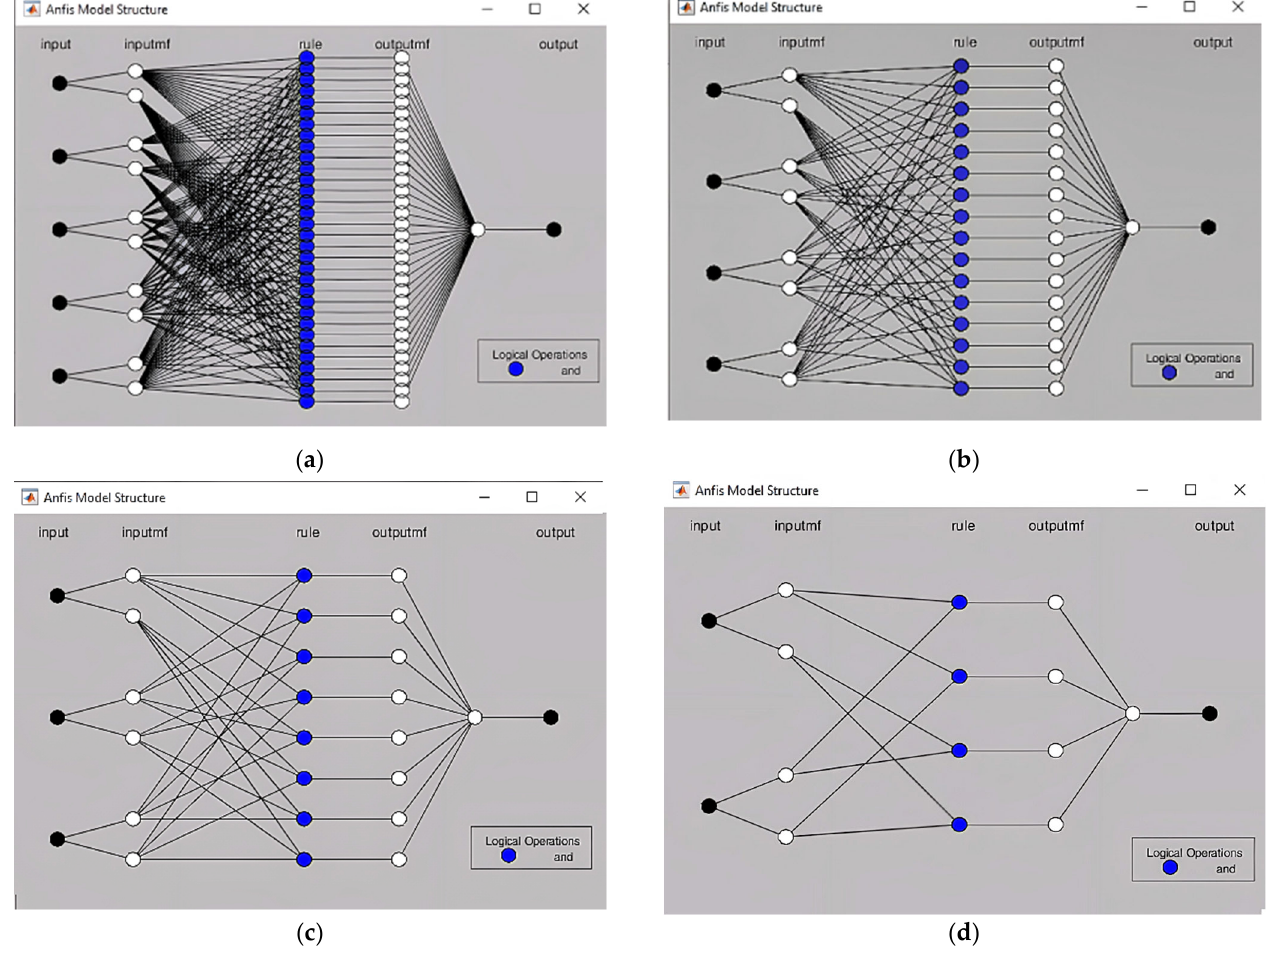
Figure 7. Different architectures of ANFIS models using the grid partition method; ( a ) N = 5, FS = 2; ( b ) N = 4, FS = 2; ( c ) N = 3, FS = 2; ( d ) N = 2, FS = 3.